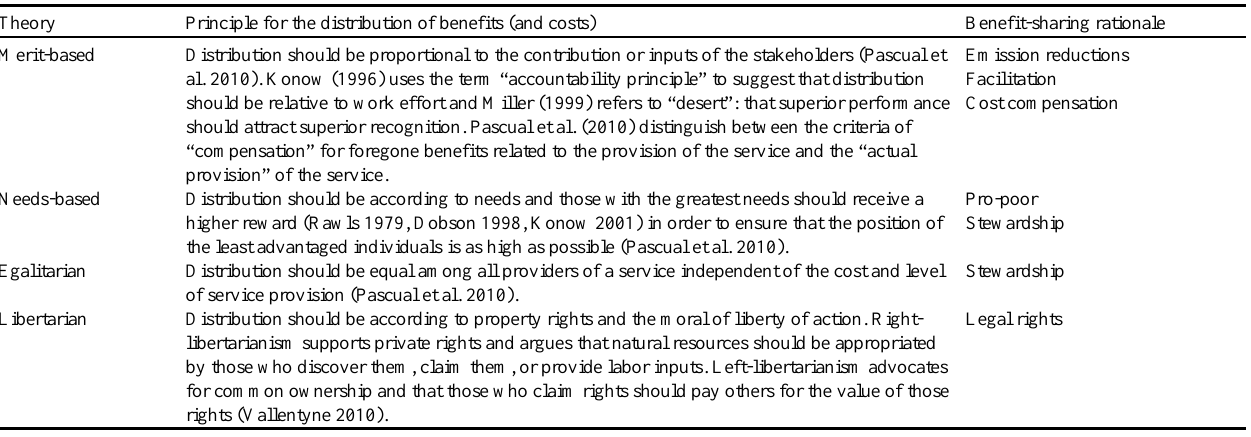
Table 3 . Relationship between selected principles of distributive equity (following McDermott et al. 2012 and Pascual et al. 2010) and the benefit-sharing